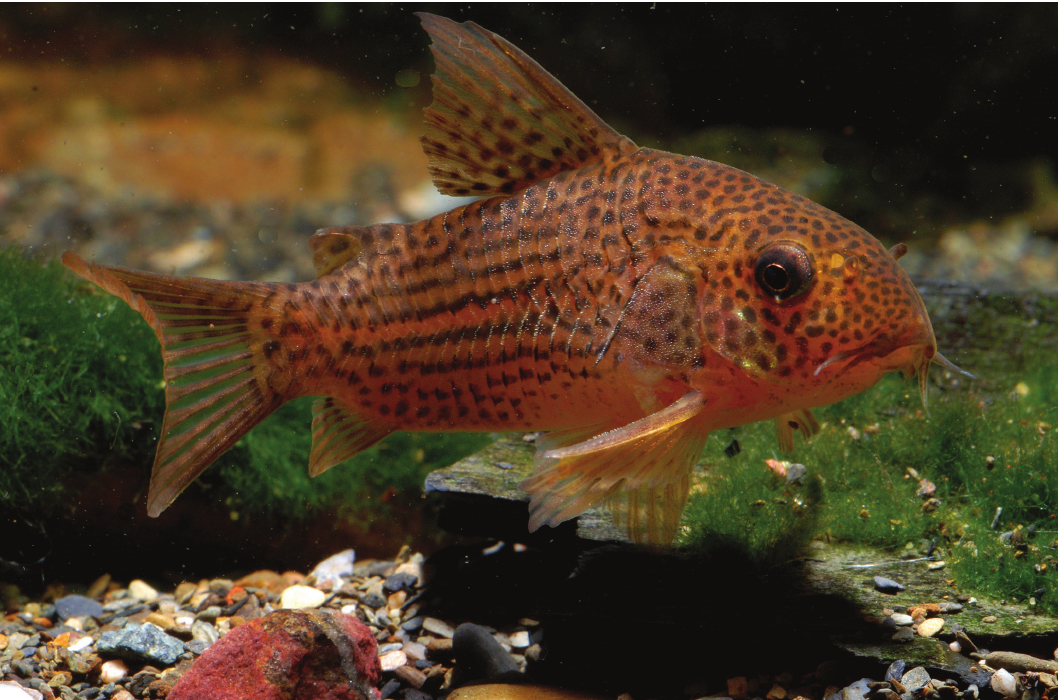
Fig. 5. Aquarium specimen of Corydoras eversi , nearly 37.0 mm SL, showing its peculiar bright orange color pattern. Photo by Hans-Georg